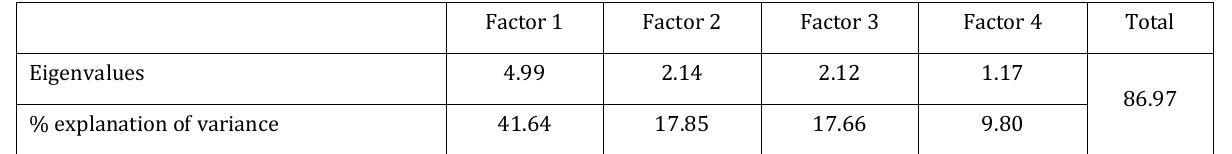
Table 2. Eigenvalues and variance